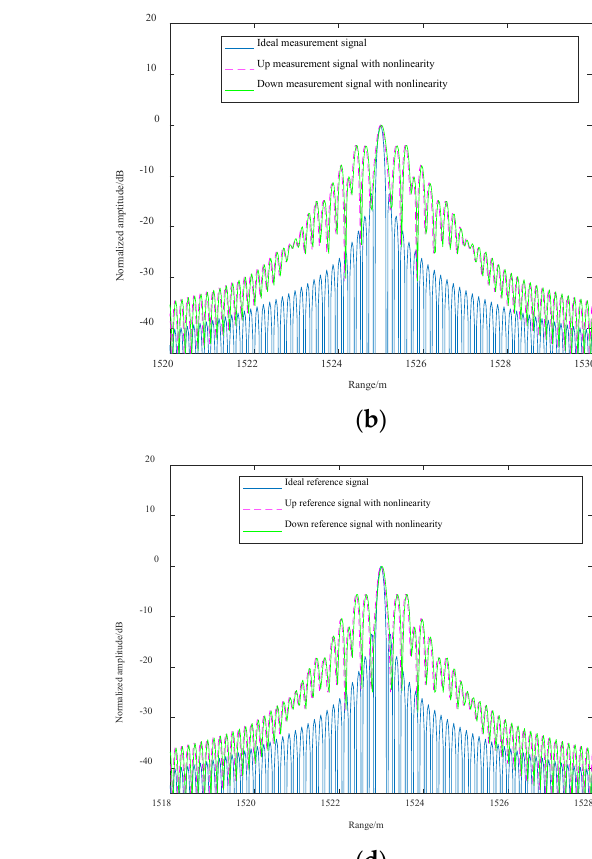
15 of 27 Table 1. Parameters of frequency modulation continuous wave (FMCW) Lidar. Parameters